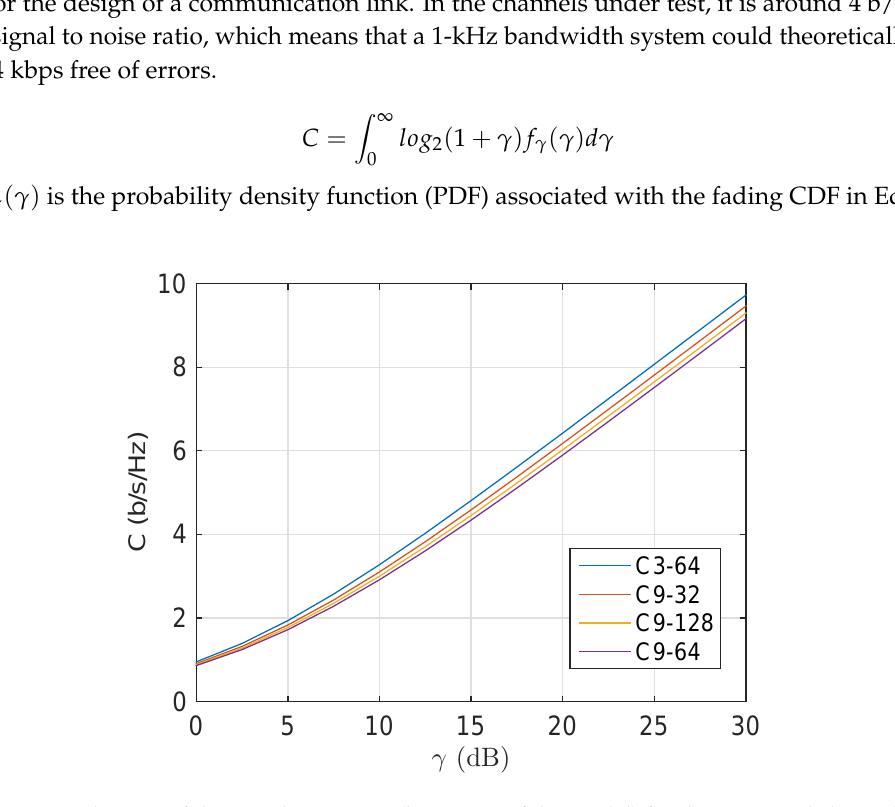
Figure 7. Evaluation of the ergodic capacity (by means of the model) for the measured channels with TS = 200 m and ASD = 25